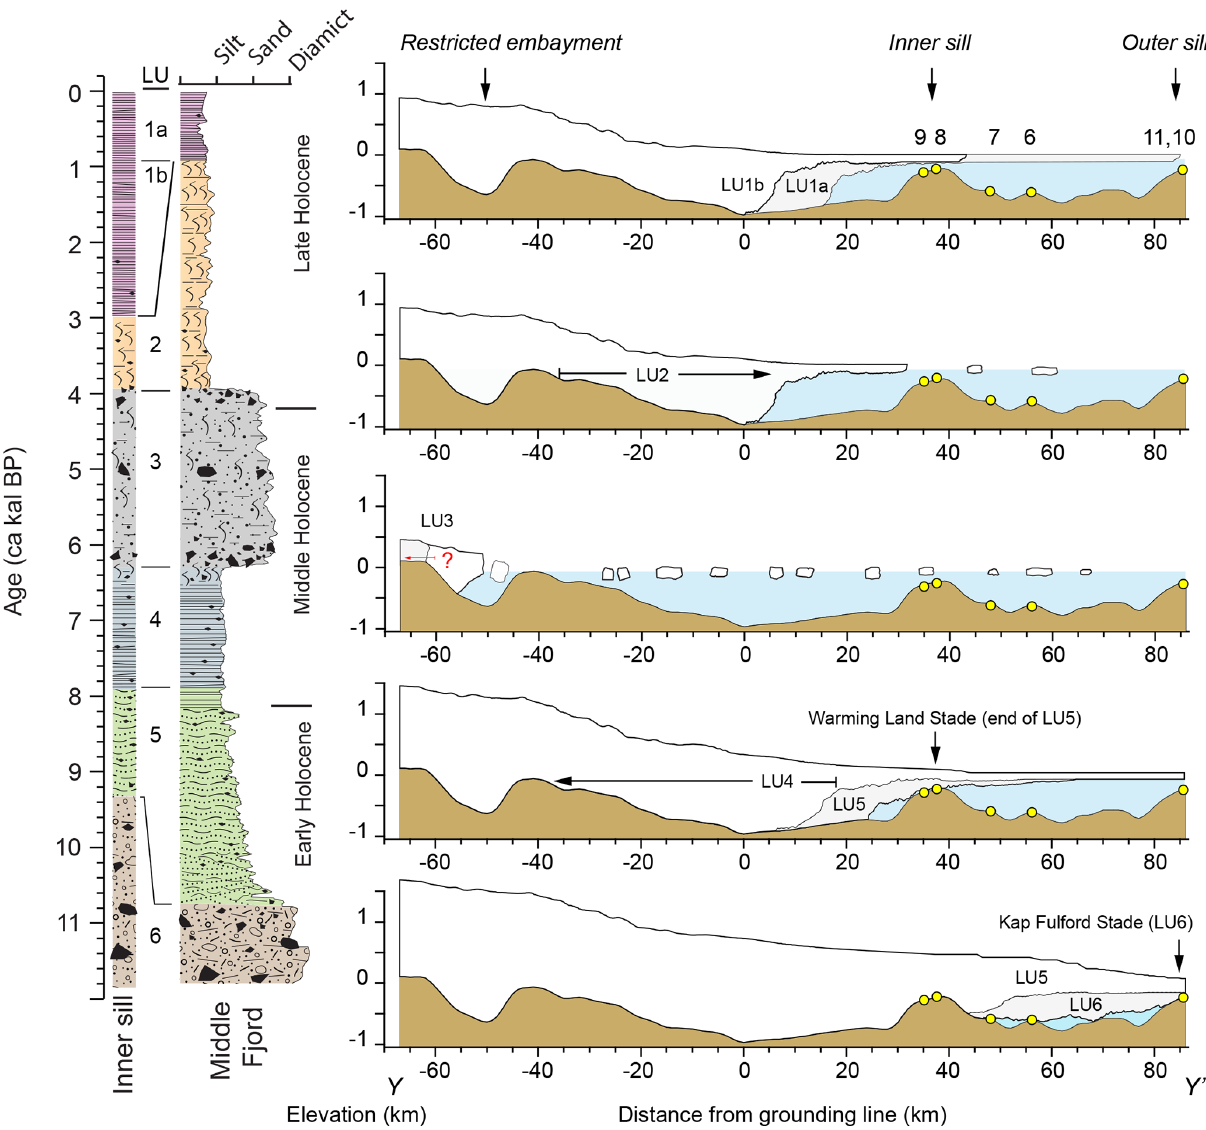
Figure 11. Generalized lithology and corresponding reconstructions of Ryder Glacier and ice tongue during deposition of the lithologic units. The profile location is illustrated in Fig. 11. The bathymetry was re-gridded from BedMachine v3 (Morlighem et al., 2017) after adding bathymetric data collected during the Ryder 2019 expedition. Substantial modifications to the former digital elevation model exist around the now mapped inner sill and beneath the modern ice tongue (see Supplement for details). Yellow dots indicate approximate positions of coring stations discussed in the